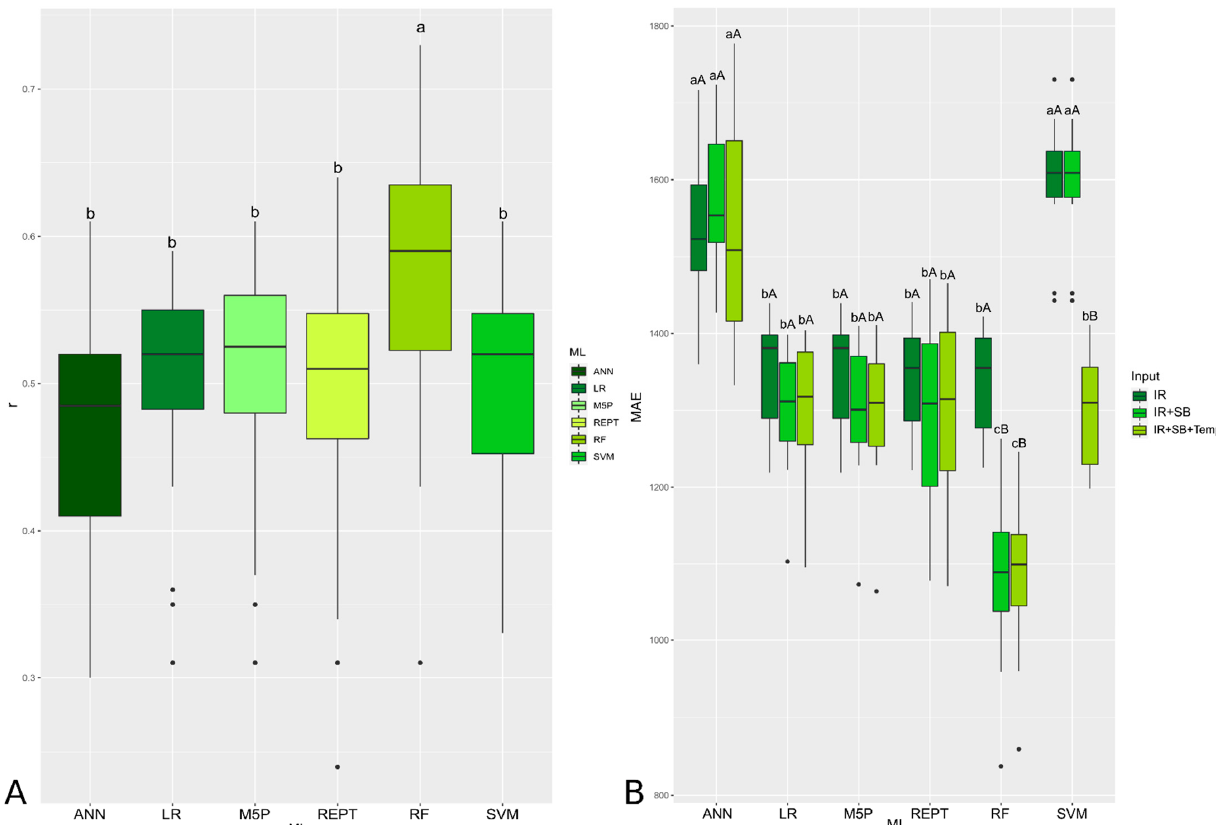
Figure 4. Boxplot for grouping Pearson correlation means (r) ( A ) and mean absolute error (MAE) ( B ). Means followed by the same uppercase letters for the different inputs and the same lowercase letters for the different ML algorithms do not differ by the Scott–Knott test at 5% probability. ML: